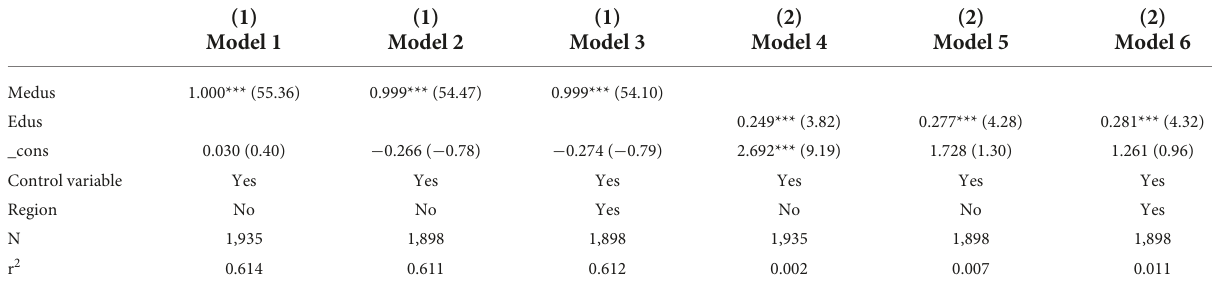
TABLE 4 Estimation results of instrumental variable